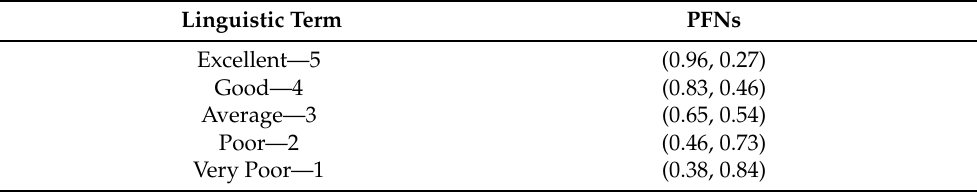
Table 2. Linguistic terms for rating the importance of criteria and decision makers.